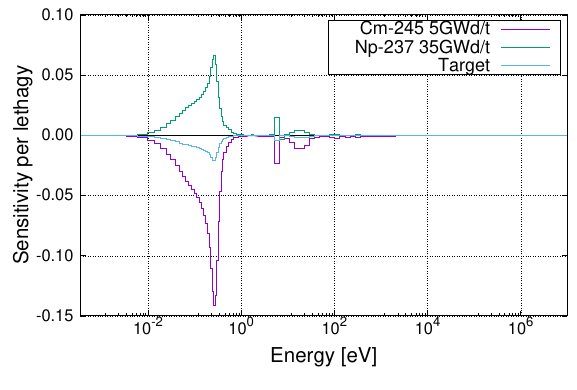
Figure 7. Decomposed sensitivities of fictitious parameters to Pu-241 capture cross section in Case 4